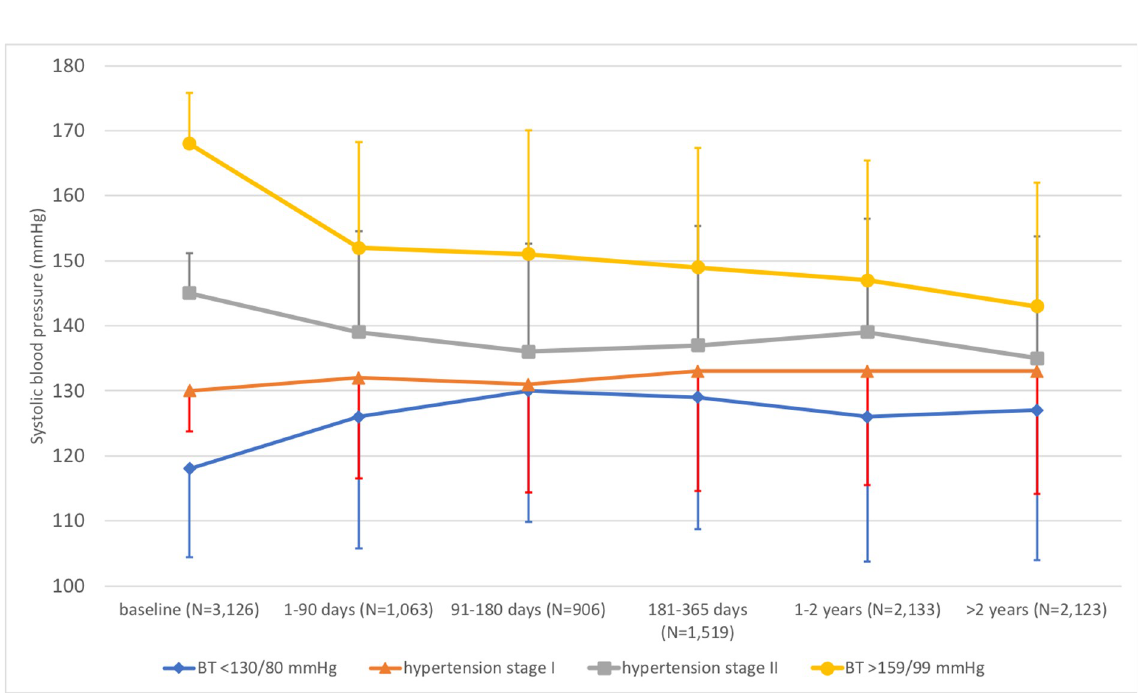
Fig 5. Changes in systolic blood pressure after the baseline examination in Healthy Ageing Initiative (HAI) participants, based on blood pressure category at baseline. The figure is based on a total of 7,744 follow-up measurements in 3,126 HAI participants. Means and standard deviations are presented. Hypertension stage 1: systolic blood pressure of 130–139 mm Hg or diastolic blood pressure of 80–89 mm Hg. Hypertension stage 2: systolic blood pressure of � 140 mm Hg or diastolic blood pressure of � 90 mm Hg. BT, blood pressure.